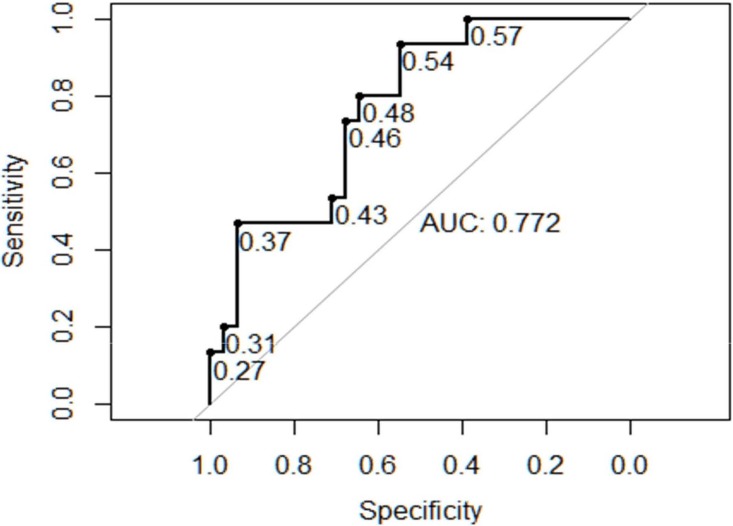
Receiver operator characteristics curve for observed to expected lung-to-head ratio (o/e LHR) and composite adverse outcome or need for intervention.